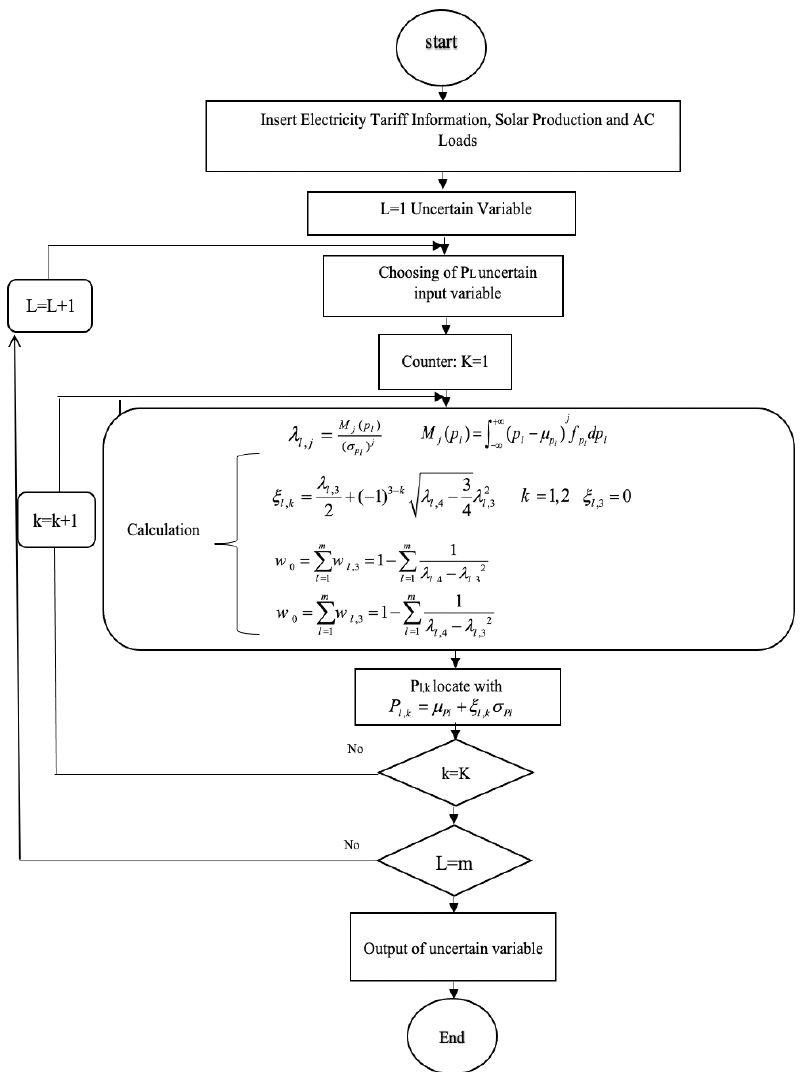
Figure 2. 2m + 1strategy.